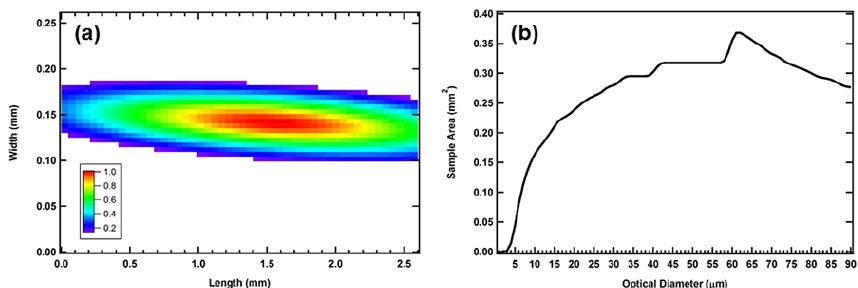
Figure 4. (a) This contour plot shows the normalized scattering intensity across the sensitive sample area of the backscatter cloud probe (BCP). The contours values are the ratio of scattering intensity to the maximum value. (b) The sample area as a function of droplet diameter is shown in this